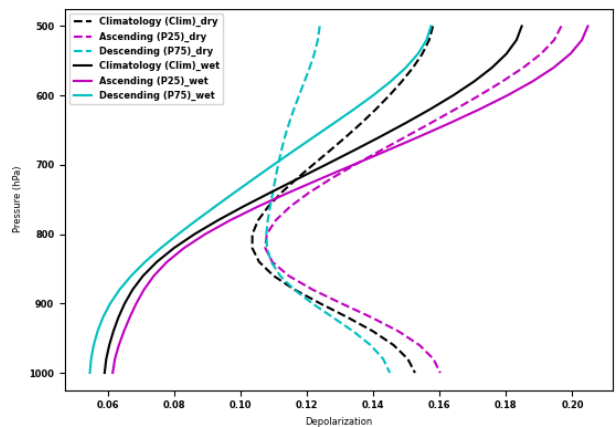
Figure 9. The vertical structure of depolarization ratio for two rela- tive humidity groups when relative humidities are between 20%– 60% (drier conditions, dashed lines) and between 60%–100% (wetter conditions, solid lines). The three colors show climatologi- cal, ascending (P25) and descending (P75)